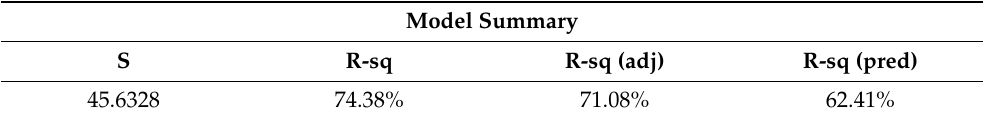
Table 2. Summary of the regression